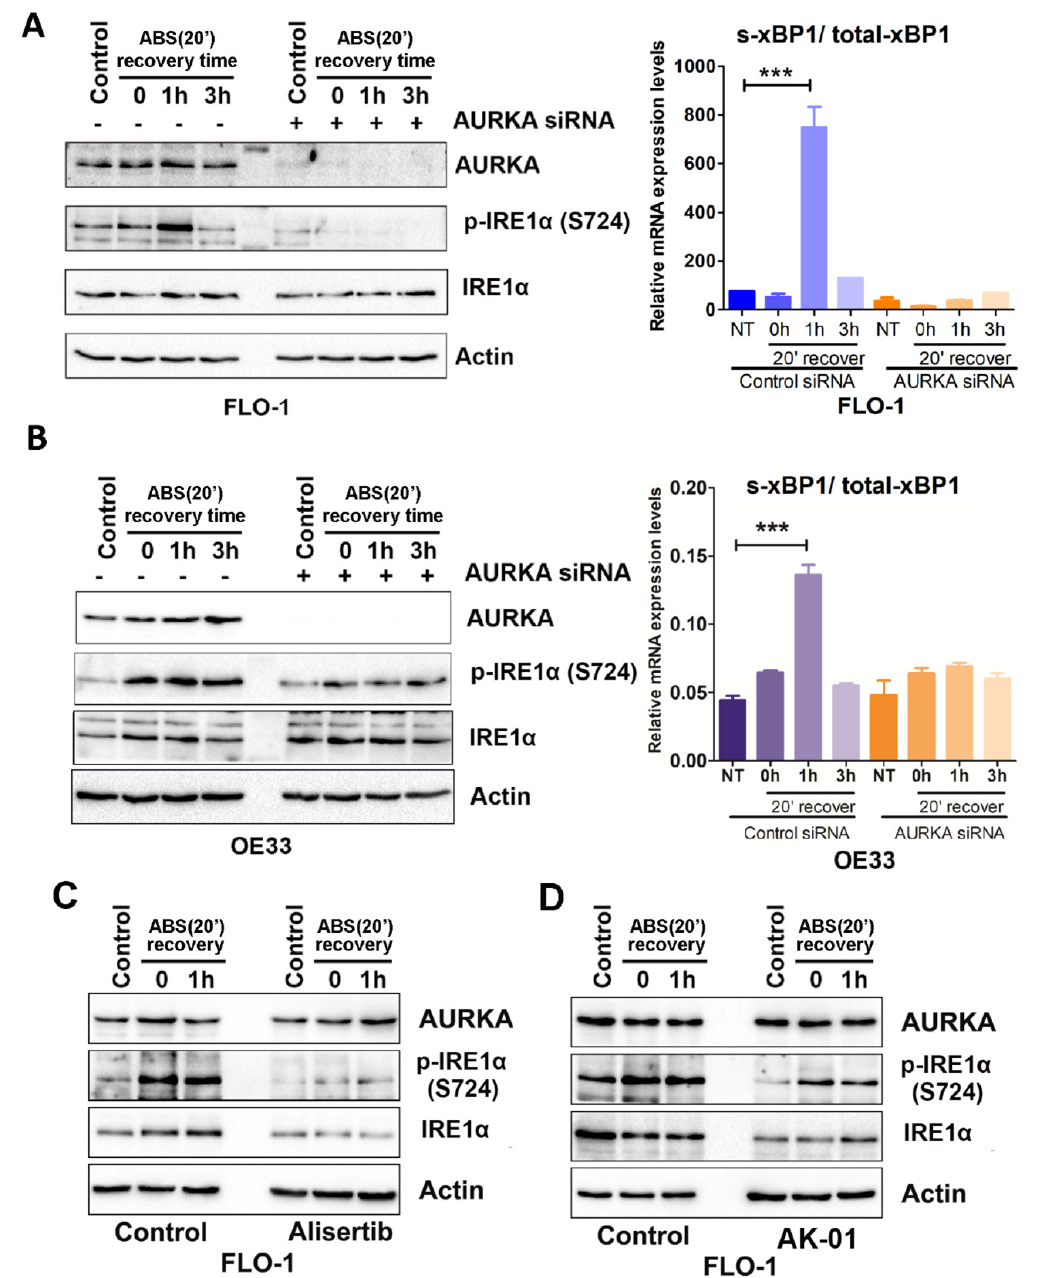
Figure 3. ABS induces IRE1α phosphorylation and activation depending on AURKA in EAC ( A ). Left panel: Western blot analysis of AURKA, p-IRE1α (S724), IRE1α, and β-actin protein expression in control siRNA or AURKA siRNA transfected FLO-1 cells with control or ABS (pH 4.0, 200 μM, 20′) exposure followed by recovery at indicated time courses (0, 1 h or 3 h). Right panel: qRT-PCR analysis of the ratio of spliced-xBP1 (s-xBP1)/total-xBP1 in the same cells as ( A ) left panel. ( B ) Similar results in OE33 cells as in ( A ). ( C ) Western blot analysis of AURKA, p-IRE1α (S724), IRE1α, and β-actin protein expression in FLO-1 control cells and alisertib 200 nM 48 h pretreated cells with control or ABS (pH 4.0, 200 μM, 20′) exposure followed by recovery at indicated time courses (0 or 1 h). ( D ) Similar results as in C in FLO-1 control cells and cells with AK-01 200 nM 48 h pretreatment. *** p < 0.001.